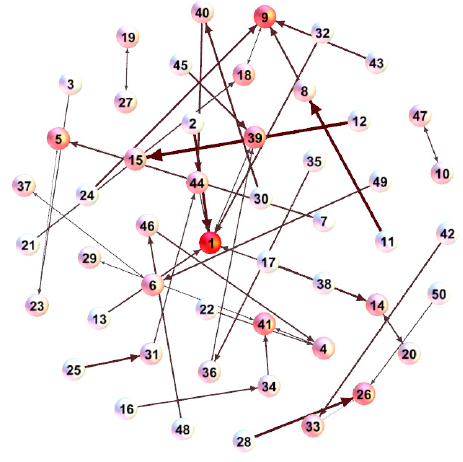
Figure 18. The spatial structure graph for T01 at generation 100.